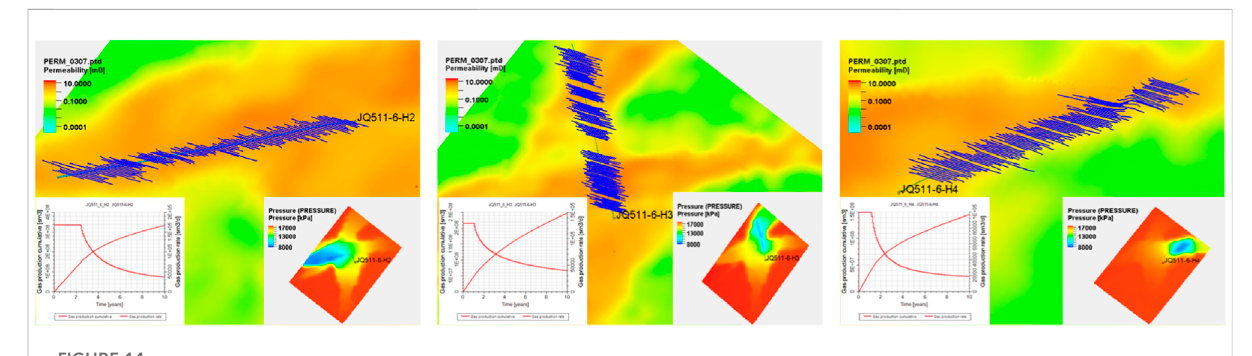
FIGURE 14 Simulation results of Well H2, Well H3, and Well H4 on JQ511